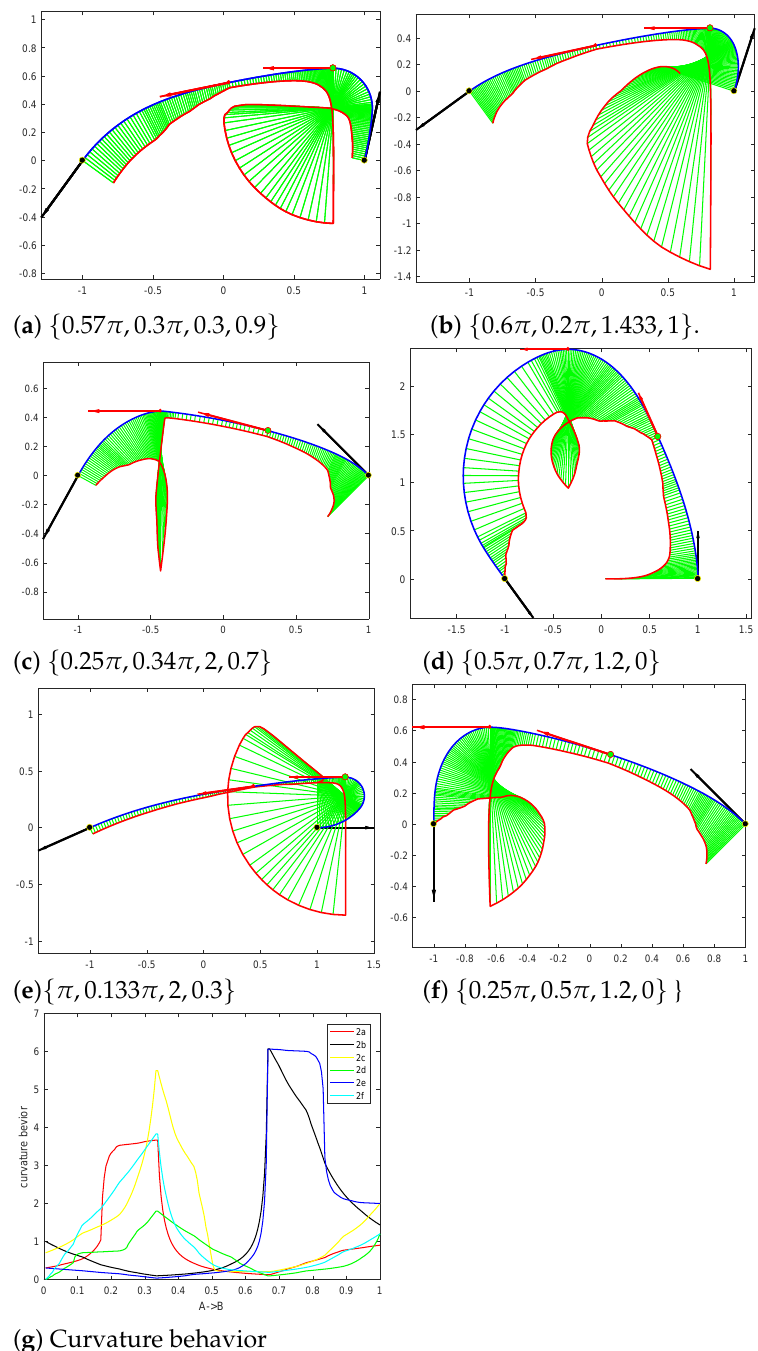
Figure 14. Example 2. Three piecewise spirals interpolating nonspiral data. These examples illustrate that the curves are G 2 continuous. The presented algorithms may sometimes fail to obtain curves with smooth curvatures. Although the implementation effect may deviate from other algorithms in a few cases, the advantage of our algorithms is that for arbitrary G 2 Hermite data, we can use three piecewise spiral interpolations at most. Other existing methods either use segmented splines to design curves or cannot guarantee solutions. That is, only special G 2 Hermite data can be interpolated by spirals, but general data cannot be